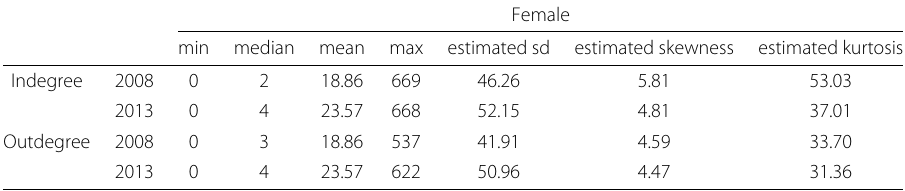
Table 4 Summary statistics and estimated skewness and kurtosis for the female indegree and outdegree distributions in 2008 and 2013